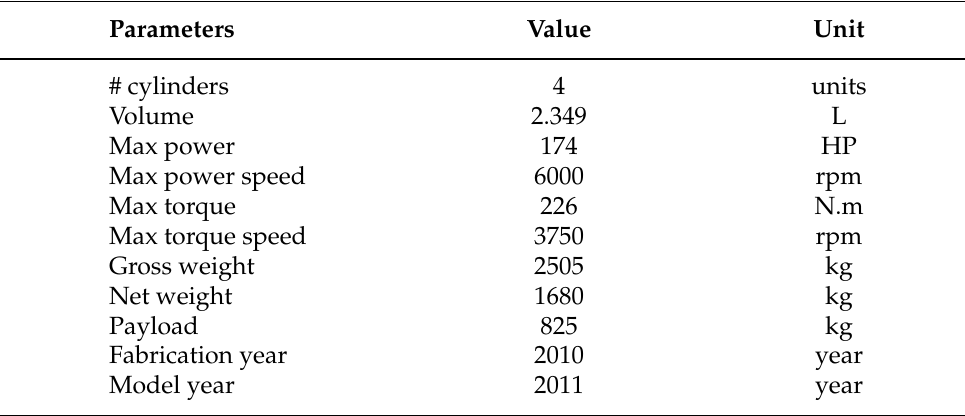
Figure 2. Circuit for tests in TCT in Lima Metropolitana. Table 2. Hyunday Santa Fe 2010